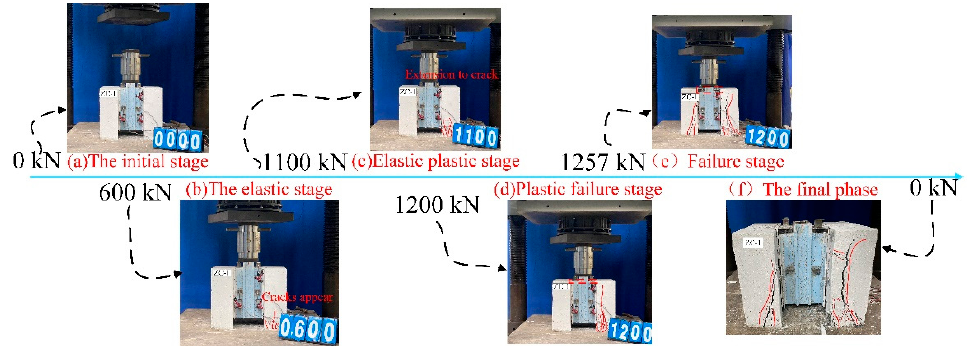
Figure 10. Main test phenomena of ZC-1 specimen.